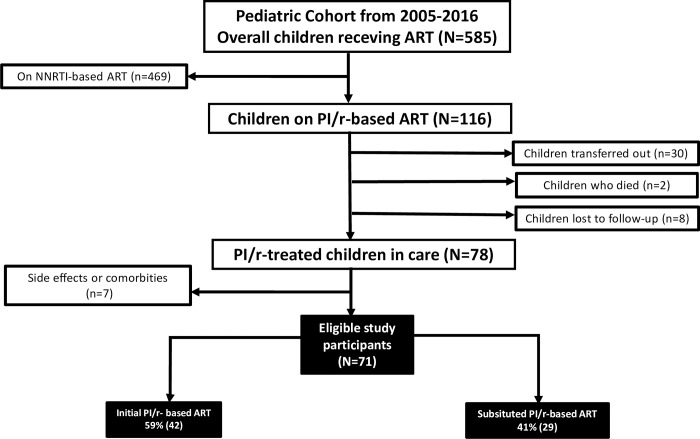
Flow chart for enrolment of the study participants.